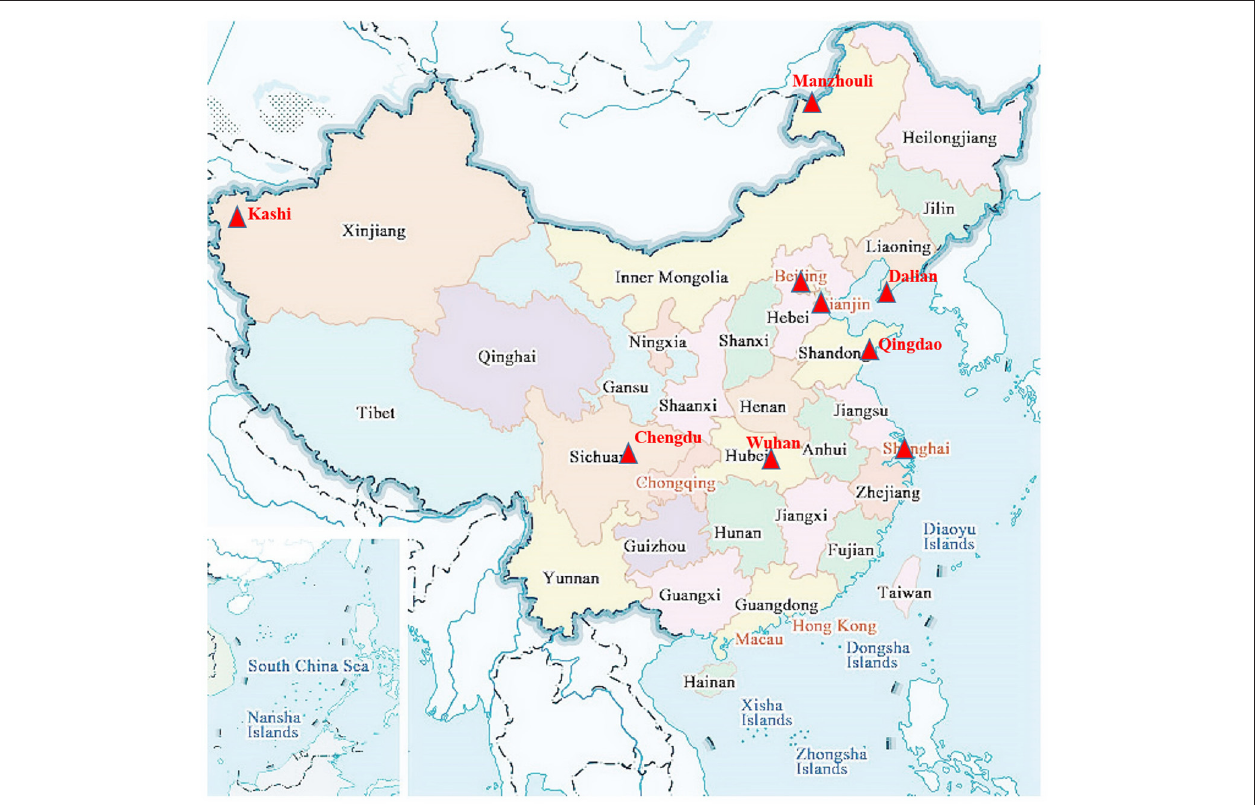
FIGURE 1 | Geographical epidemiological characteristics of eight cities during the sporadic COVID-19 outbreaks in China. Dalian, Tianjin, Qingdao, and Shanghai are coastal cities, and Kashi and Manzhouli are border